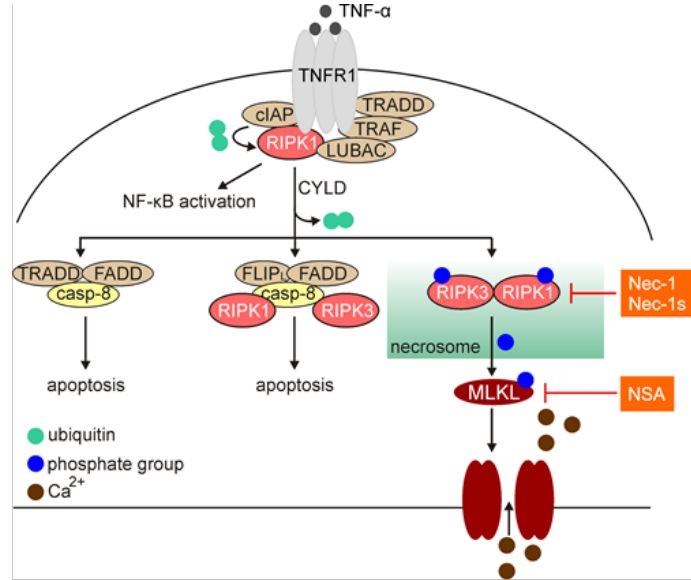
Figure 3. Necroptotic signaling pathway exemplified by tumor necrosis factor alpha (TNF- α )-mediated activation of tumor necrosis factor receptor (TNFR)1. Activated TNFR1 forms a multi-protein complex I that transmit either pro-survival response (NF- κ B activation) or cell death response, which is mediated by cylindromatosis (CYLD)-dependent deubiquitylation of receptor-interacting protein kinase 1 (RIPK1). Complexes-IIa / b are formed when the activation of caspase-8 can proceed apoptosis. Upon inhibition of caspase-8, complex IIc (necrosome) mediates activation of mixed lineage kinase domain-like (MLKL) by phosphorylation at Ser 358 that results in pore formation in the plasma membrane and Ca 2 + influx. Compounds that inhibit necroptosis, including necrostatin-1 (Nec-1), necrostatin-1s (Nec-1s), and necrosulfonamide (NSA) are shown in orange